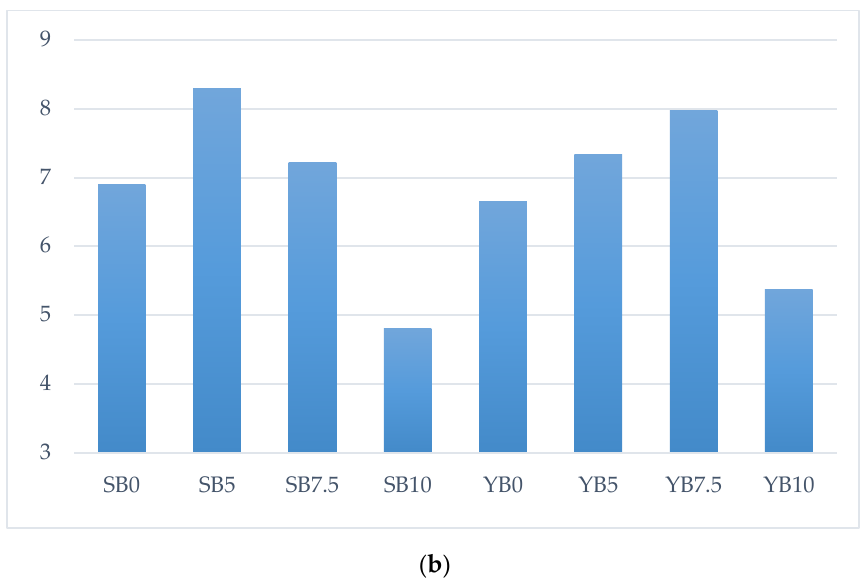
Figure 5. ( a ) Hedonic profile of cooked breads (for both crumb and crust). Significance level *** p < 0.001; ** p < 0.01; * p < 0.05; ns: not significant ( p > 0.05). ( b ) Overall hedonic indices of cooked breads (for both crumb and crust).